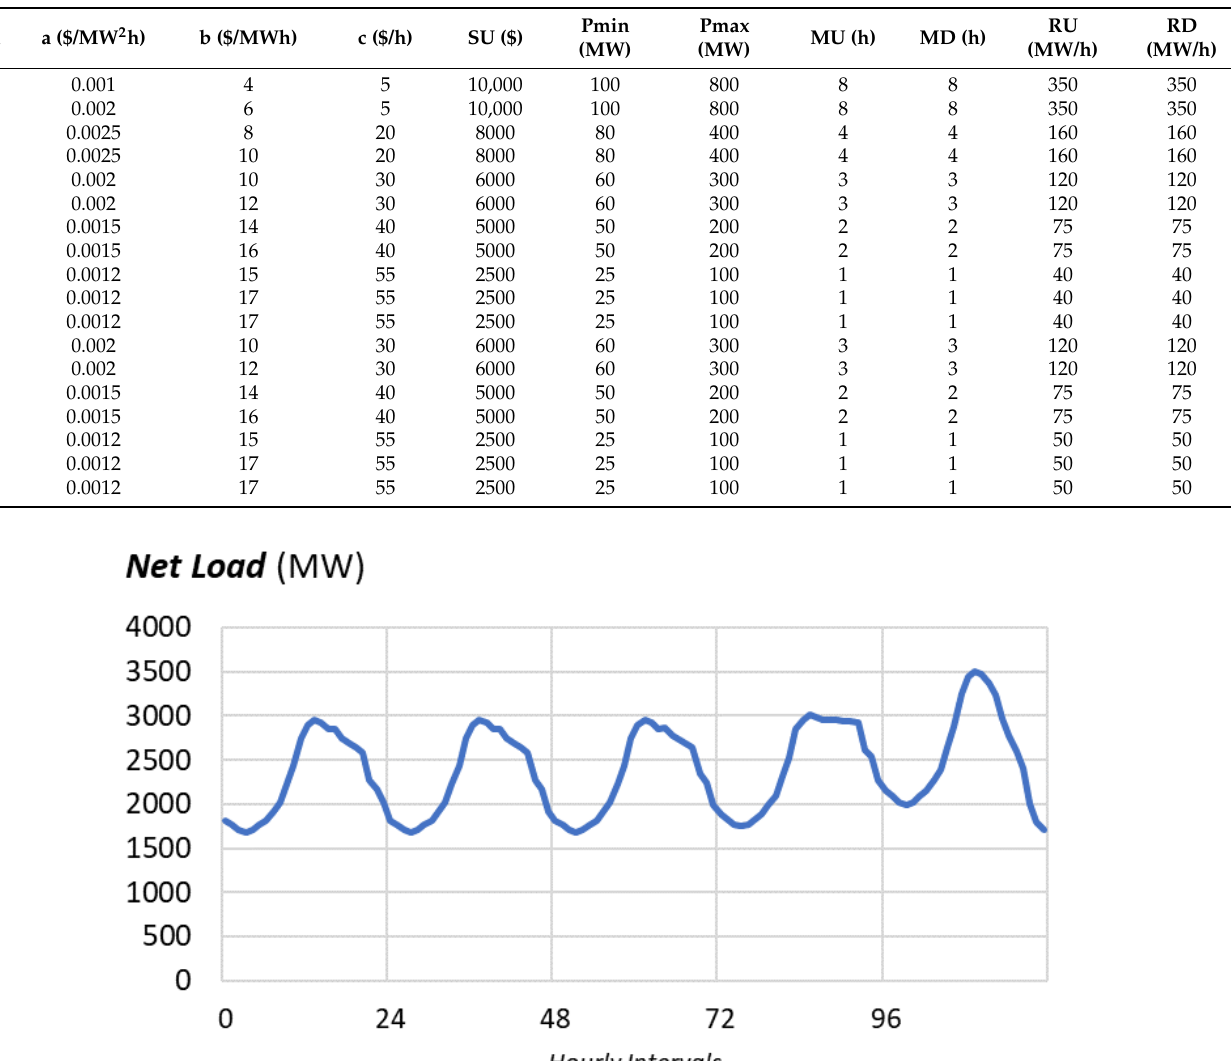
Table 1. Characteristics of the thermal generating units.